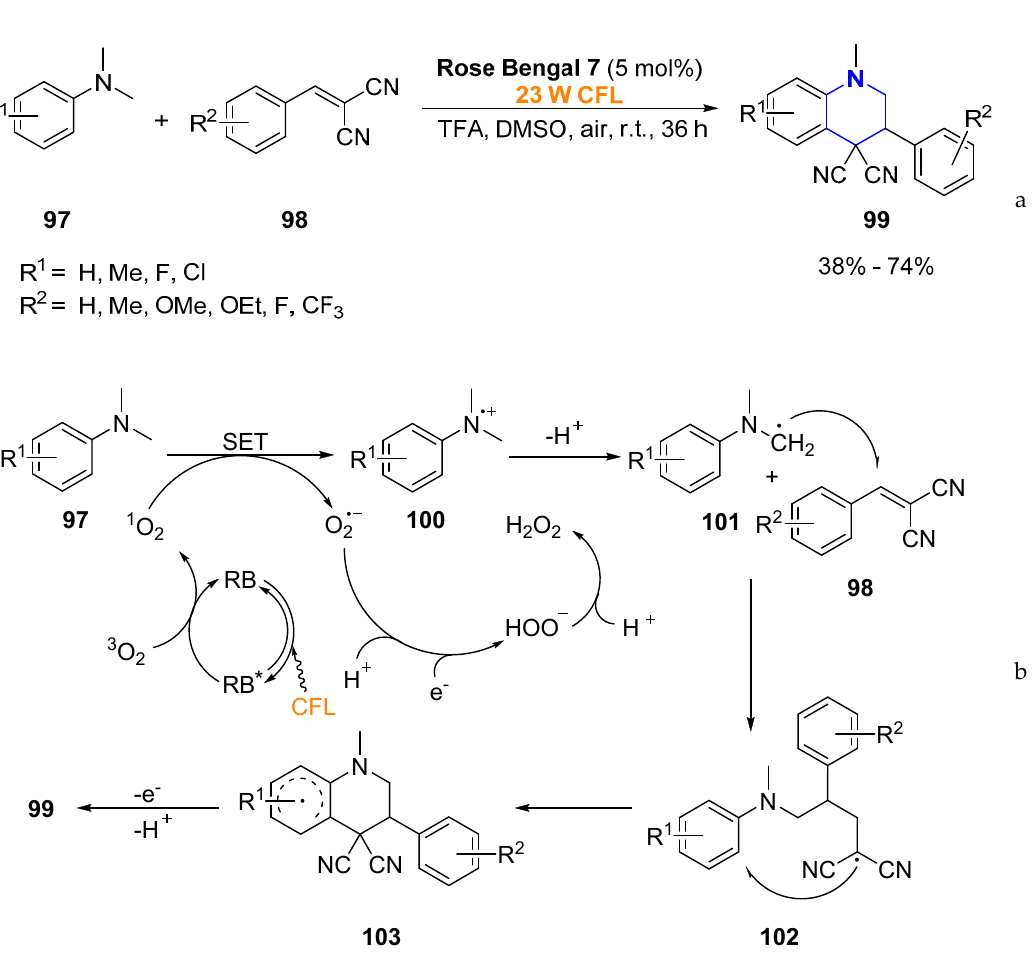
Scheme 13. ( a ), Synthesis of tetrahydroquinoline derivatives. ( b ), Proposed mechanism for